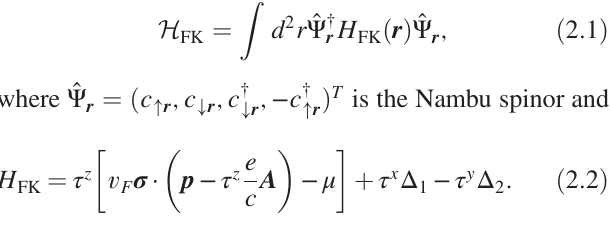
FIG. 1. The proposed setup for a solid-state realization of the SYK